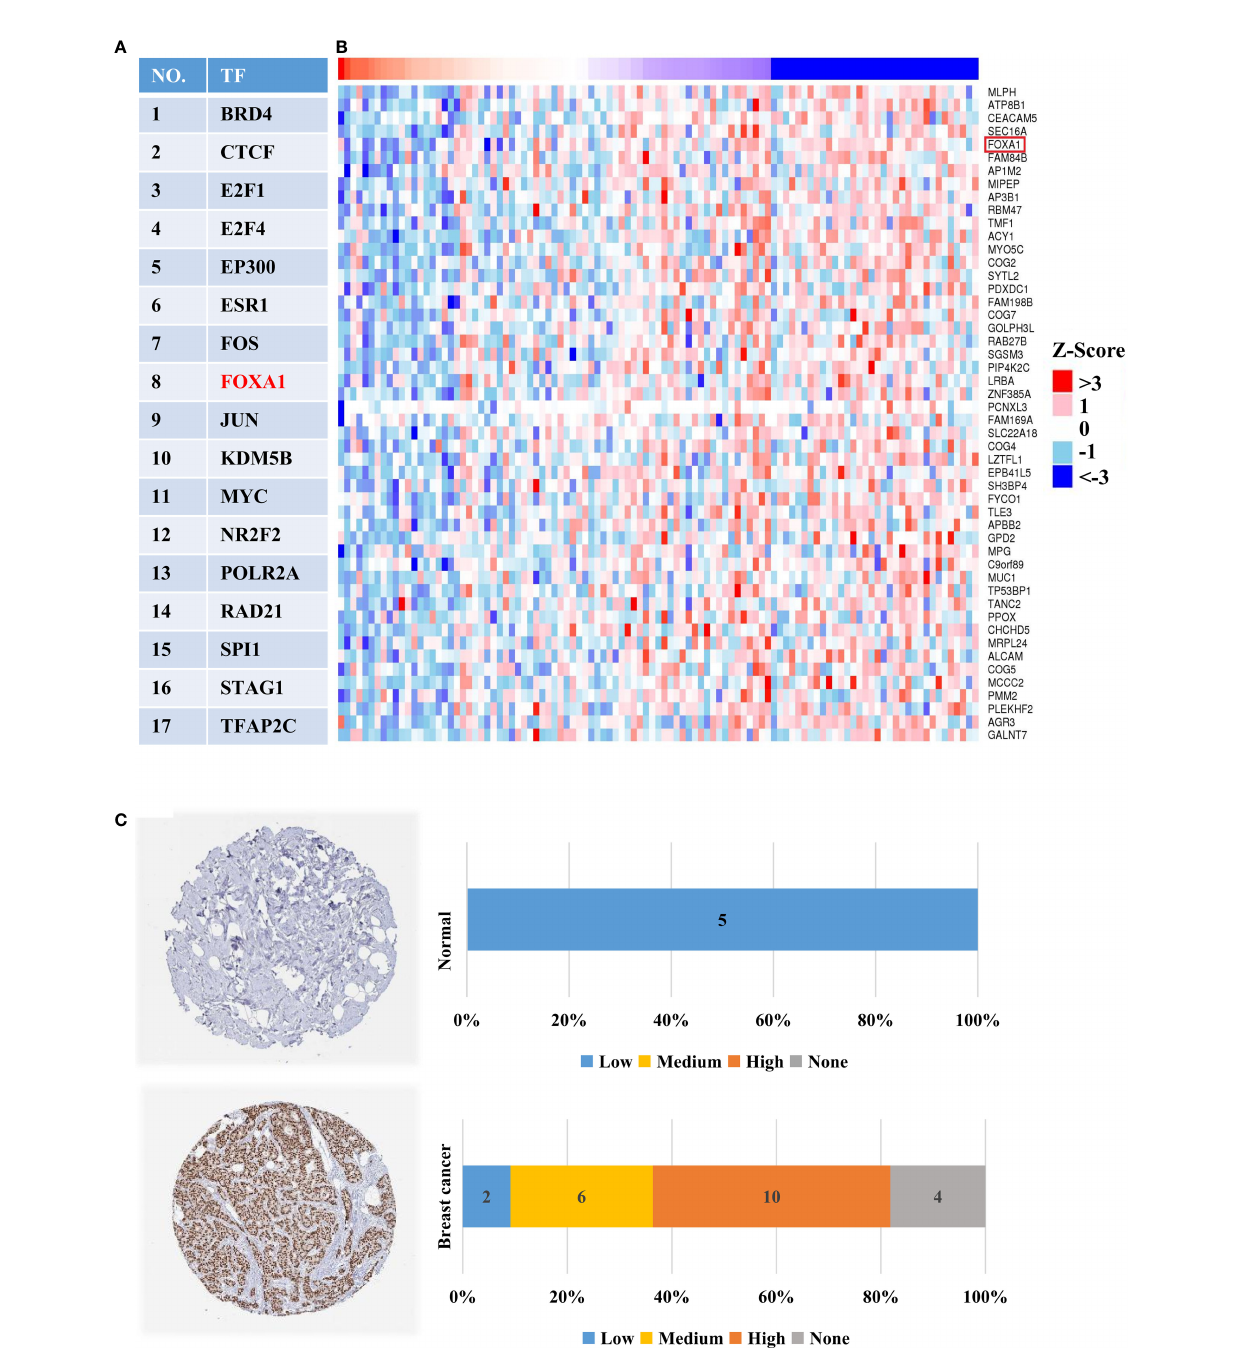
FIGURE 8 | FOXA1 was one potential TF negatively regulating the expression of HTR6 in breast cancer. (A) 17 experimentally-tested TFs of HTR6 in breast tissue were uncovered using hTFtarget database. (B) FOXA1, as one potential TF of HTR6 in breast cancer was negatively correlated with HTR6 expression. (C) The expression of FOXA1 was up-regulated in most patients with breast